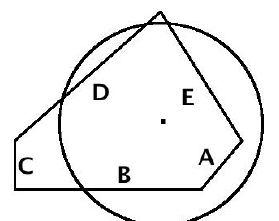
Figure 4. Voronoi cell with five sides (ABCDE) with the data point and a bounding circle. Our goal is to restrict the size of the polygon to the points lying inside the circle. Edge A will be kept, edge C will be discarded and usage of edges B, D and E will be restricted to the parts of them that lie inside the